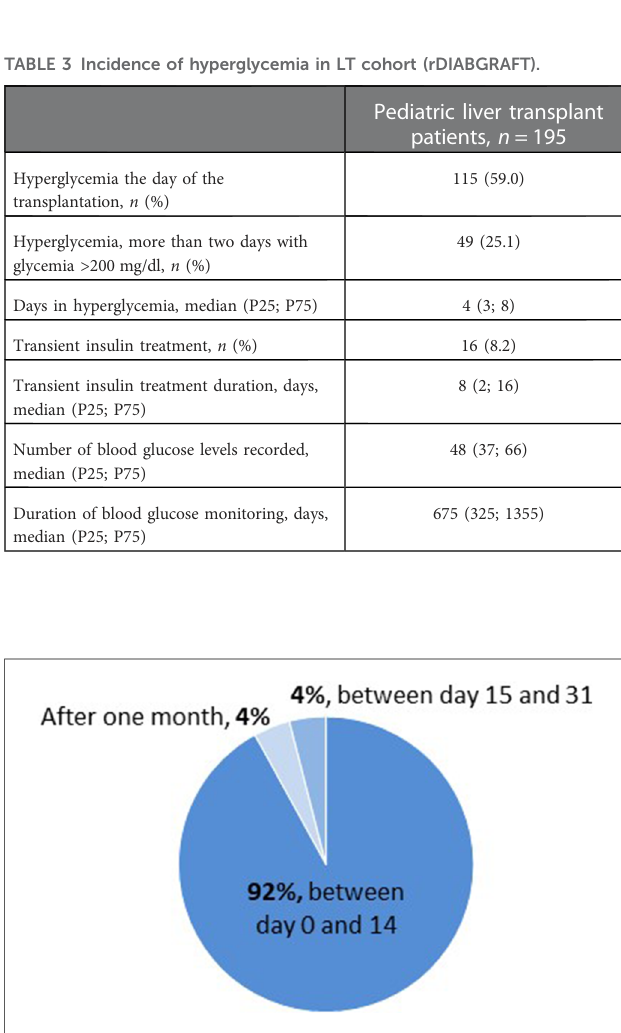
FIGURE 4 Onset of hyperglycemia in pediatric LT cohort (rDIABGRAFT). For most of our pediatric liver transplant patients (92%), hyperglycemia occurred during the fi rst two weeks after transplantation.